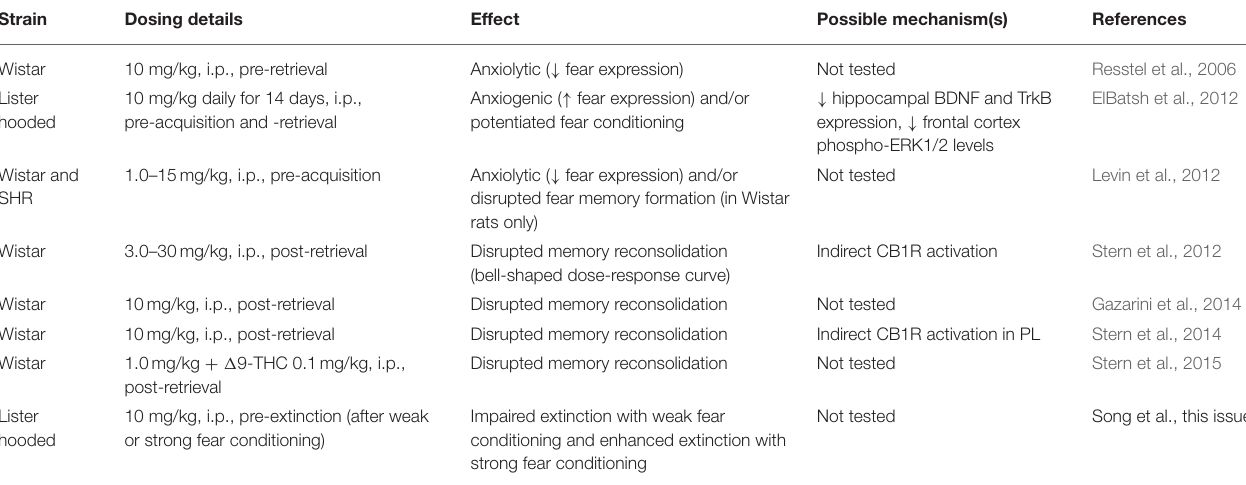
TABLE 1 | Summary of systemic CBD effects on contextual fear memory processing in male rats ( 1 9-THC, 1 9-tetrahydrocannabinol; BDNF, brain derived neurotrophic factor; CB1R, cannabinoid type1 receptor; ERK1/2, extracellular signal-regulated kinase1/2; i.p., intraperitoneal; PL, prelimbic; SHR, spontaneously hypertensive rat; TrkB, tyrosine receptor kinase